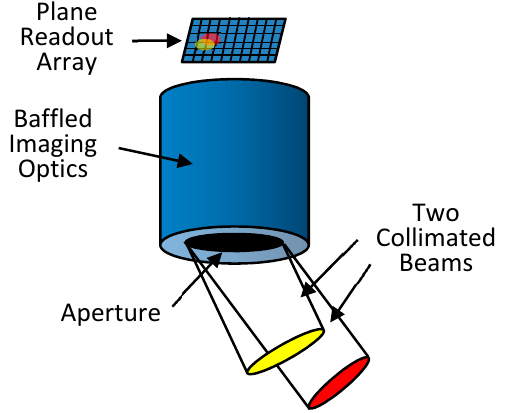
Figure 3. Schematic representation of a generic wide-field-angle earth radiation budget staring imager.